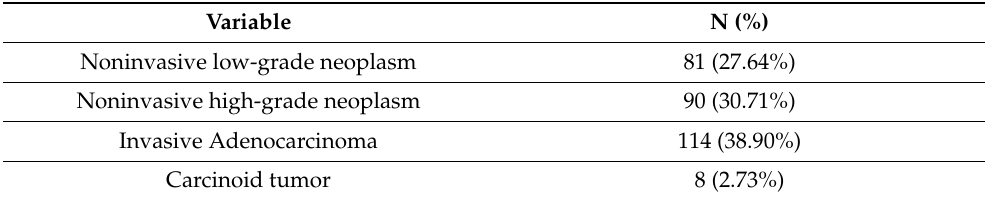
Table 1. Histological distribution of lesions at screening endoscopy. Variable N (%) Noninvasive low-grade